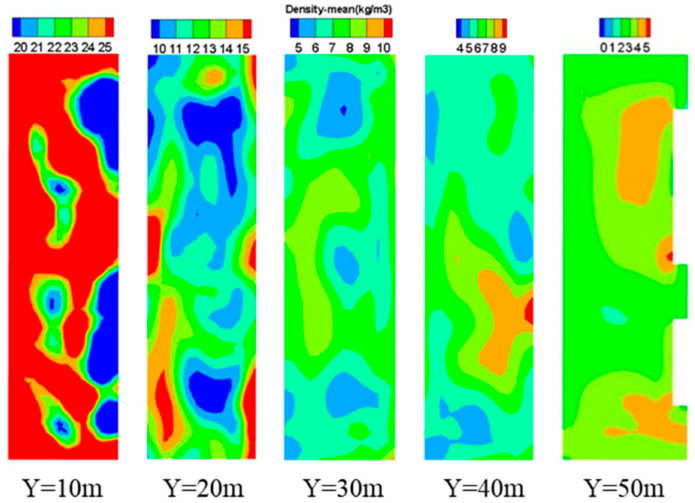
Figure 10. Material concentration distribution along the furnace height direction.